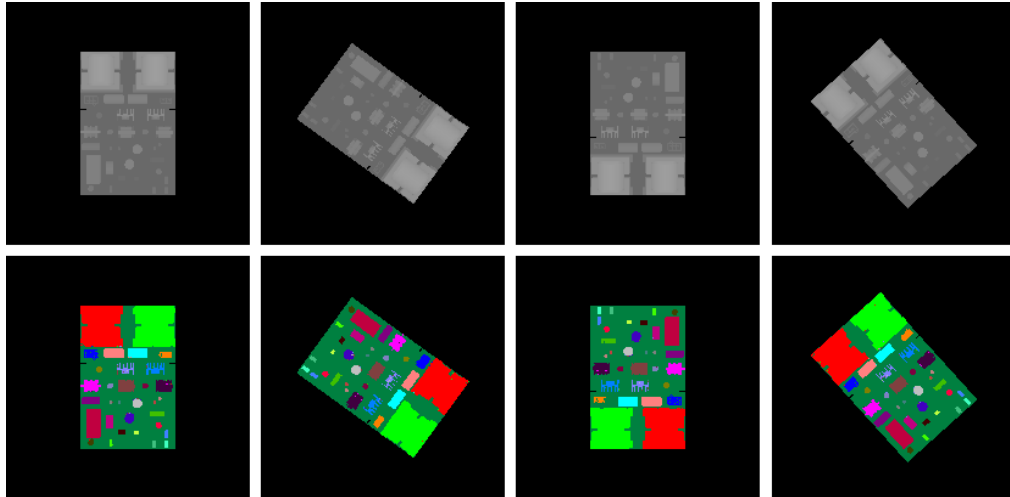
Figure 8. Synthetic depth images and the corresponding pixel classification images. The first row: synthetic depth images for test. The second row: the corresponding pixel classification images generated by the trained random forest pixel classifier.